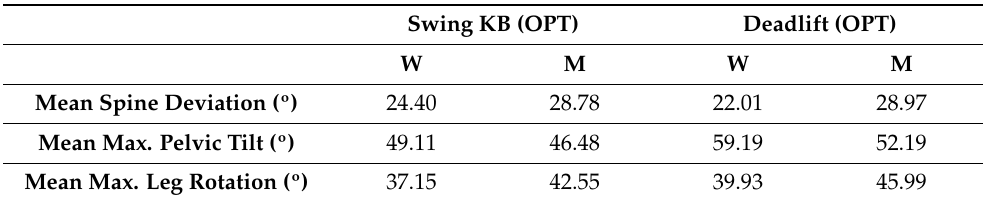
Table 5. Mean values for